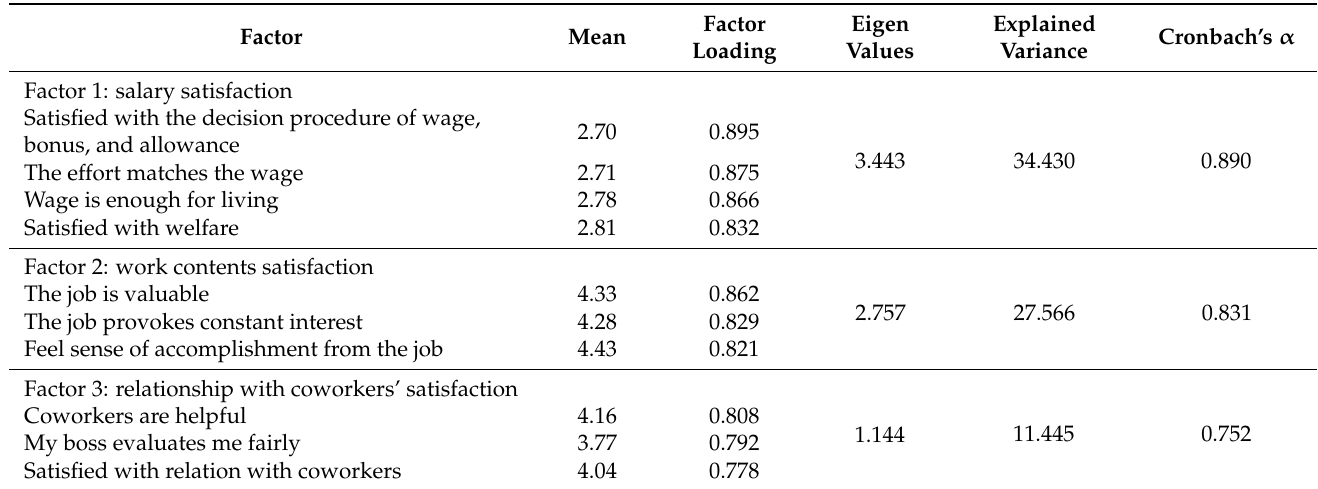
Table 3. Results of factor analysis for job performance variables.